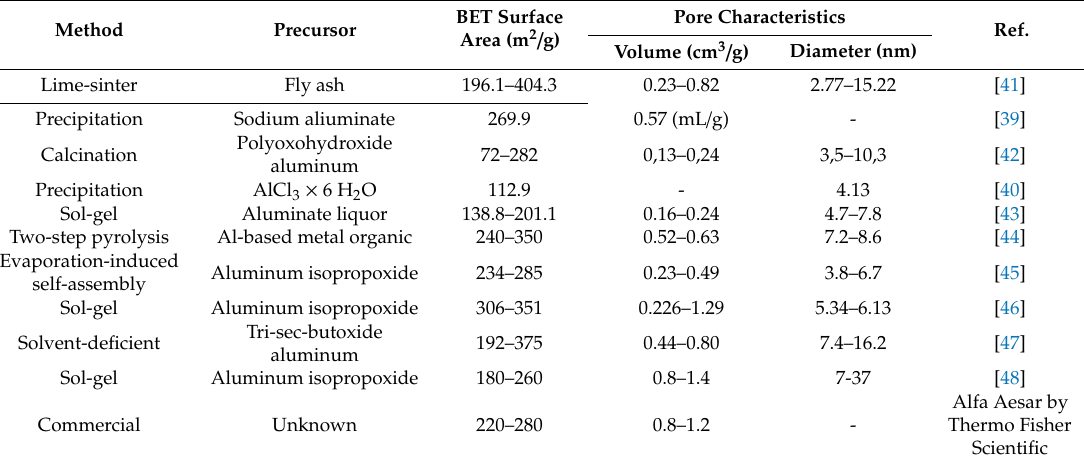
Table 2. Gamma Al 2 O 3 synthesis methods and its main